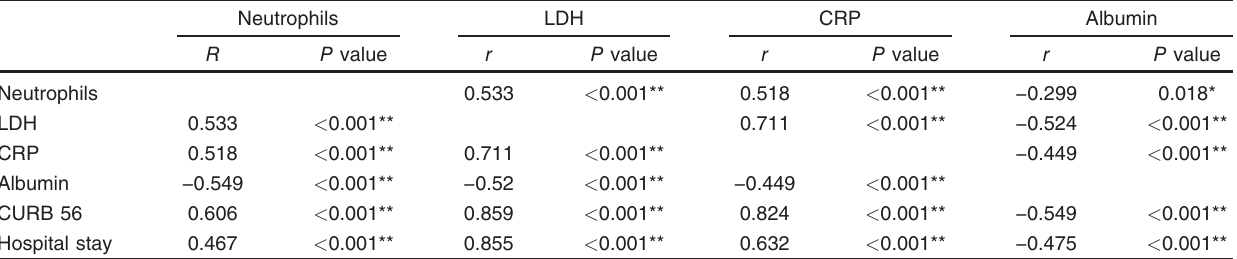
Table 3 Correlation between neutrophils, lactate dehydrogenase, C-reactive protein, and serum albumin with each other and with CURB 56 and hospital stay Neutrophils